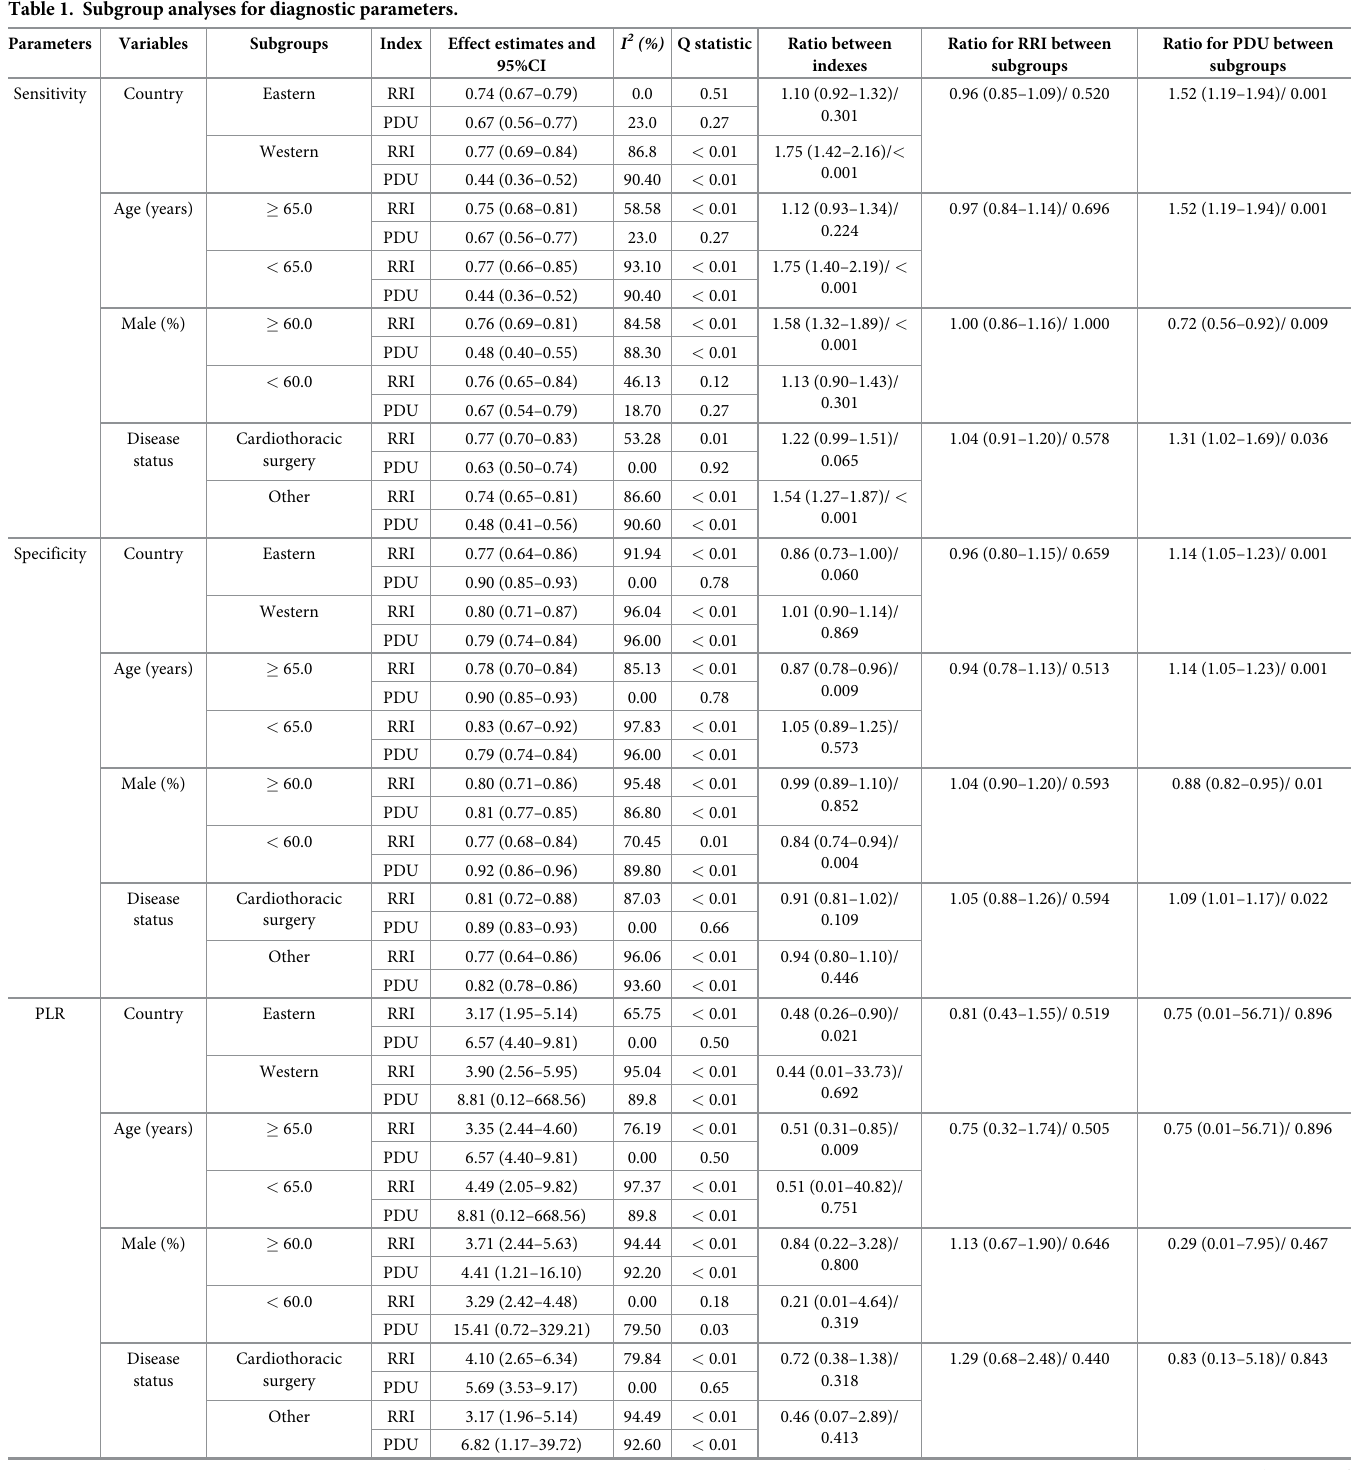
Table 1. Subgroup analyses for diagnostic